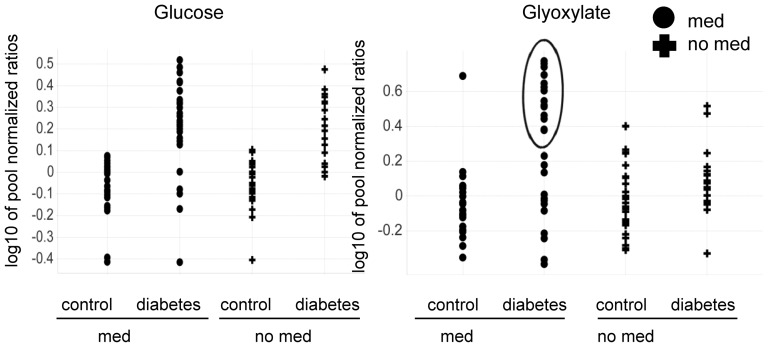
Other than glucose, glyoxylate levels are strongly increased in a defined subgroup of diabetic patients.Scatter plots of glucose and glyoxylate levels show an increase of glyoxlate during hyperglycemic stress (OGTTt = 120) which was observed to be stronger in a specific subgroup of diabetic patients with a history of anti-hypertensive medication intake. For glucose, no such specific increase in diabetic patients with a history of taking anti-hypertensive medication was seen. Subjects with anti-hypertension medication (med) are represented by circles; subjects with no history of anti-hypertensive medication (no med) are represented by crosses. Study participants were categorized as type-2 diabetics (n = 47) or control (n = 51) based on FPG and/or OGTTt = 120 levels. P-values for the difference between diabetic and control subjects in subjects with vs. subjects without a history of anti-hypertensive medication are 0.02 for glyoxylate and 0.77 for glucose.